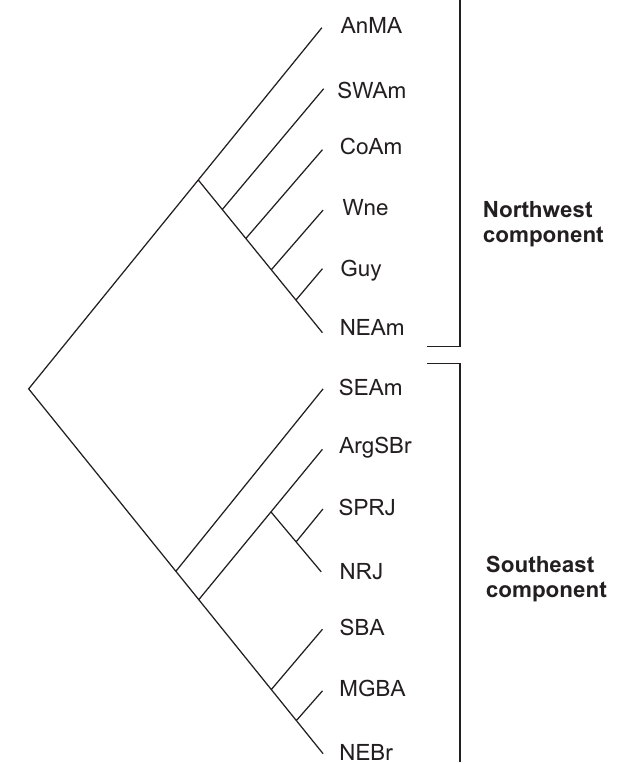
Figure 9. Historical relationship between the internal sub-compo- nents within the Southeast and Northwest components found in A MORIM & P IRES ’ (1996) classification, modified from A MORIM & P IRES (1996). Atlantic Forest component – ((ArgSBr (SPRJ,NRJ)) (SBA